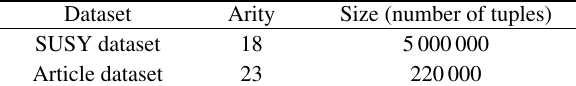
Table 2 Parameters of real